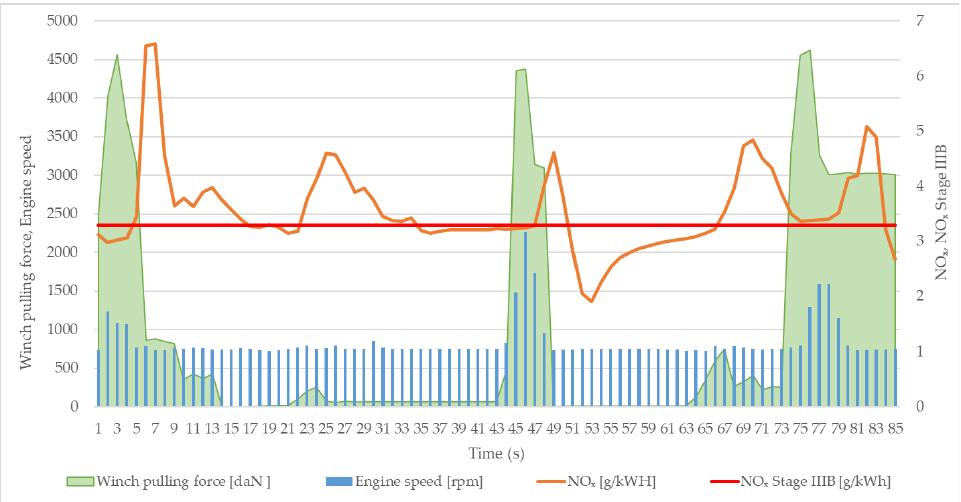
Figure 9. Comparison of NO x during engine load with EPA/COM IIIB standard.